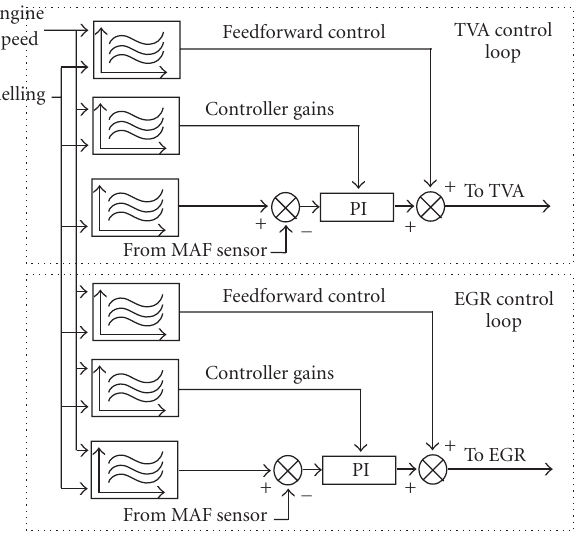
Figure 2: Standard control strategy developed by BOSCH.